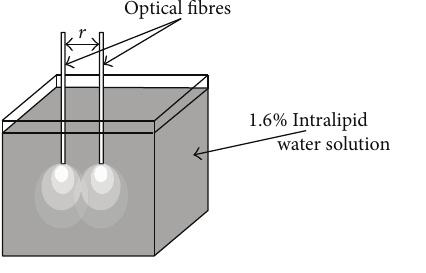
Figure 3: Scheme of the experimental setup. Table 1: Optical properties of the brain tissue model for Photosens emission wavelength (668 nm) [15, 16].